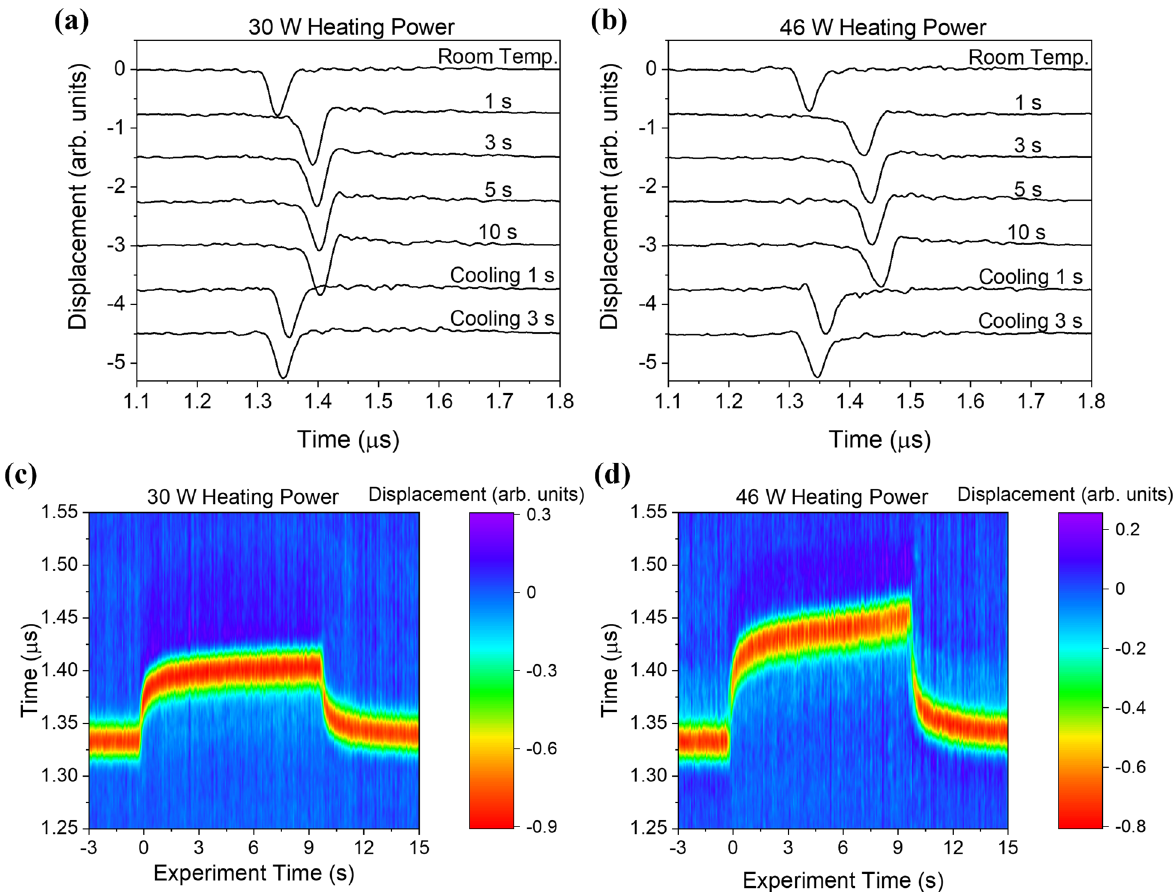
Figure 5. Laser ultrasonic signals in Ti-6Al-4V samples with a source to detector distance of 4.0 mm at room temperature, heating times of 1, 3, 5, and 10 s, and cooling times of 1 and 3 s for CW laser heating powers of ( a ) 30 W and ( b ) 46 W. Temporal evolution of the displacement fields, where experiment time of 0 s indicates the time at which the heating laser is turned on, for CW laser heating powers of ( c ) 30 W and ( d ) 46